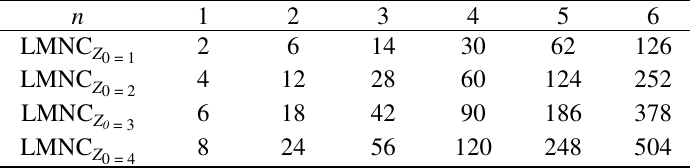
Table 1. The number of branches for AB